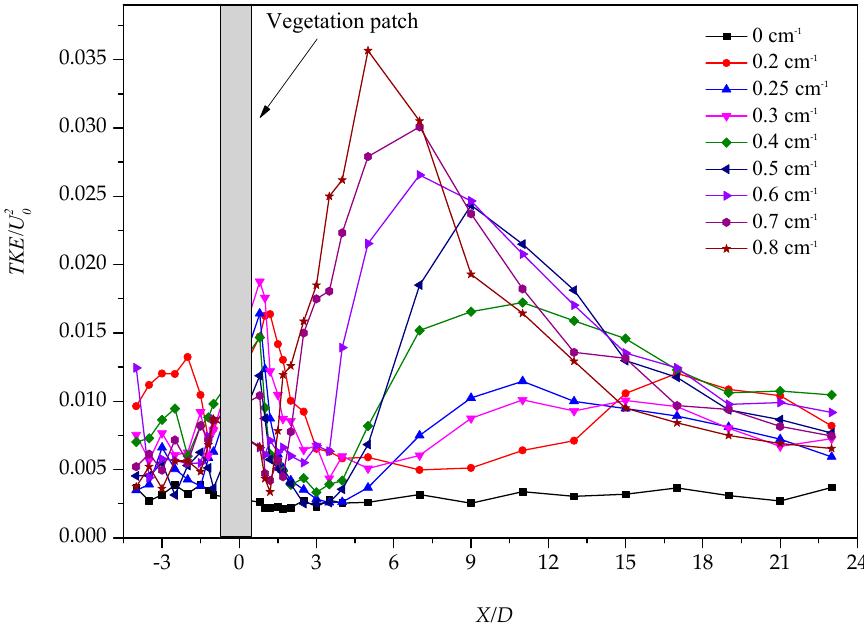
Figure 2. The stream-wise distribution of the turbulent kinetic energy ( TKE ).